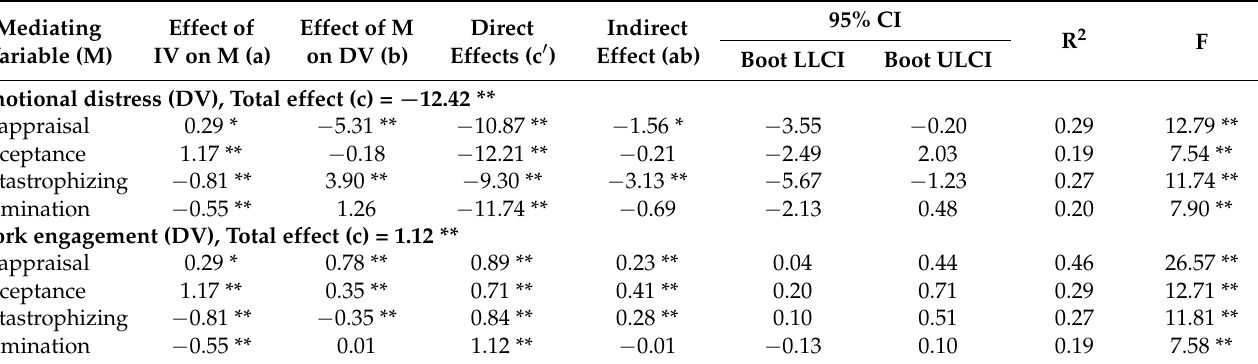
Figure 1. Conceptual model of the mediation model. ( a ) Emotion regulation strategies as a mediator be-tween the C2C-IT intervention and emotional distress. ( b ) Emotion regulation strategies as a mediator between the C2C-IT intervention and work engagement. Table 3. Mediation of the effect of the C2C-IT intervention (IV) on the dependent variables (DV) through ER strategies (N =